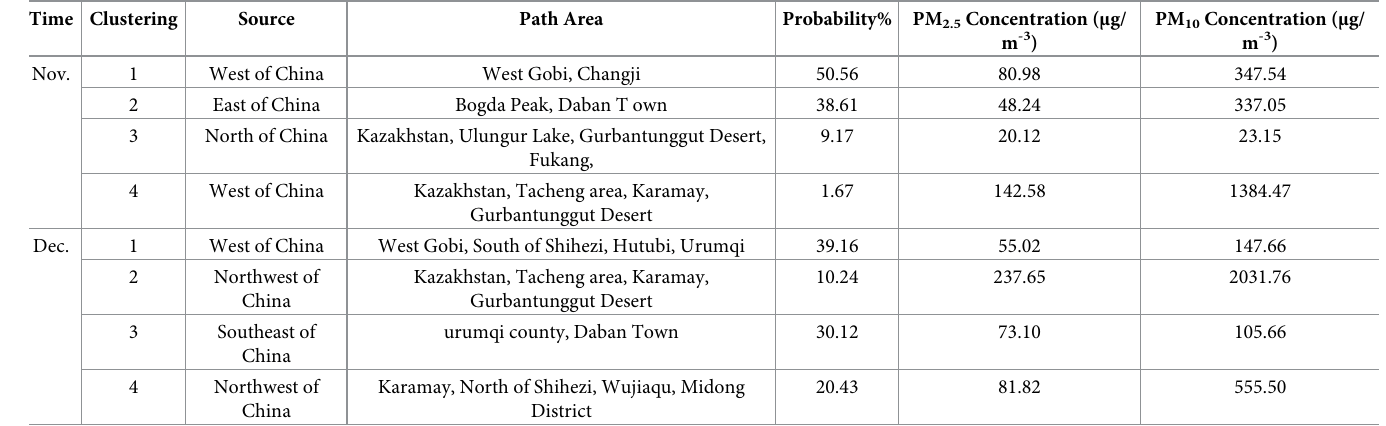
Table 4. Distribution characteristics and average pollutant concentration of all backward trajectory. Time